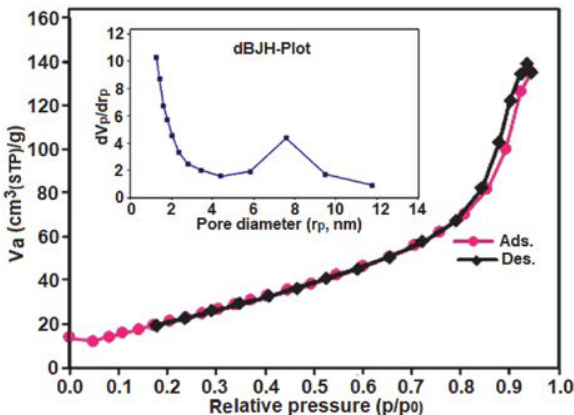
Figure 9. N 2 adsorption–desorption isotherm of the Bi 2 O 2 CO 3 / CoFe 2 O 4 30% sample. The inset is the pore size distribution